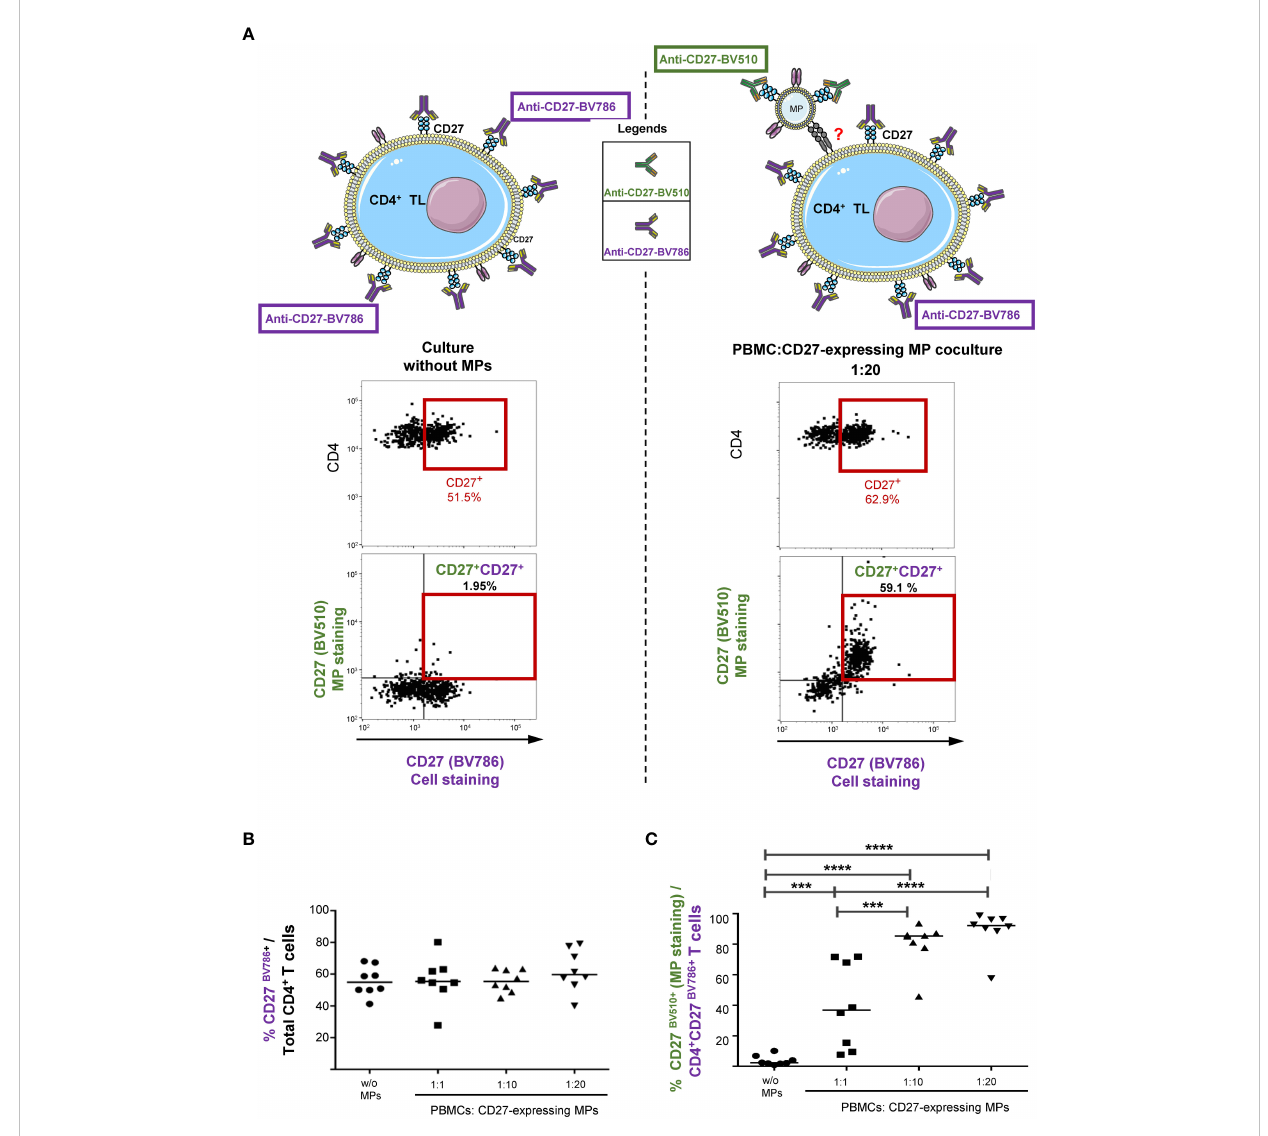
FIGURE 3 Impact of CD27 + MP binding on the pre-existing CD27 phenotype of the CD4 + TLs. (A) Schematic representation of the assay, and example of the gating strategy used to determine the CD27 expression of CD4 + TLs (PBMCs were stained with anti-CD4 and anti-CD3 antibodies; CD4 + TLs were de fi ned as having a CD3 + CD4 + phenotype). Cocultures were assessed after 18 hours for eight HDs in two experiments. Before culture, MPs were stained with a anti-CD27-BV510 antibody and PBMCs were stained with a anti-CD27-BV786 antibody. (B) Percentage CD27 BV786+ CD4 + TLs with and without coculture with MPs. (C) Percentage of CD27 BV510+ CD4 + CD27 BV786+ TLs with and without coculture with MPs. Horizontal bars indicate the median value. P values were obtained in Kruskal-Wallis and Dunn ’ s post hoc tests: **** P < 0.001, *** P <